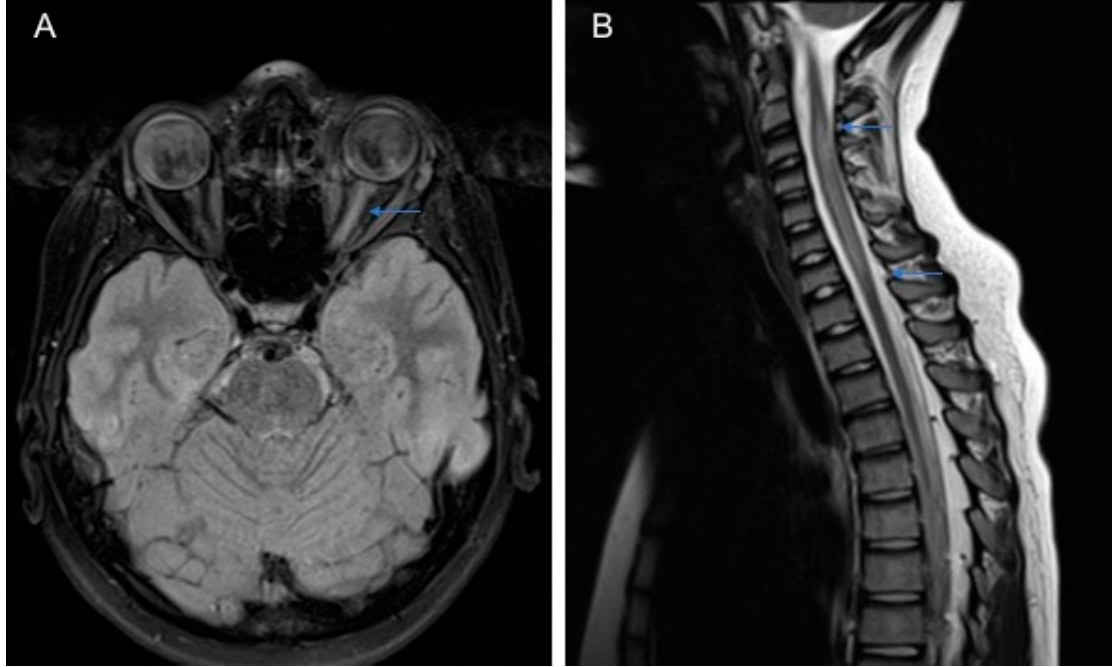
Figure 1. MRI of a 11-year-old patient with Neuromyelitis optica (NMO): ( A ) the brain axial Flair-T2 weighted image shows hyperintensity of the left optic nerve and ( B ) the spinal T2 weighted image shows cervical hyperintense lesions extending longitudinally from C3 to C7 (longitudinally extensive transverse myelitis (LETM).